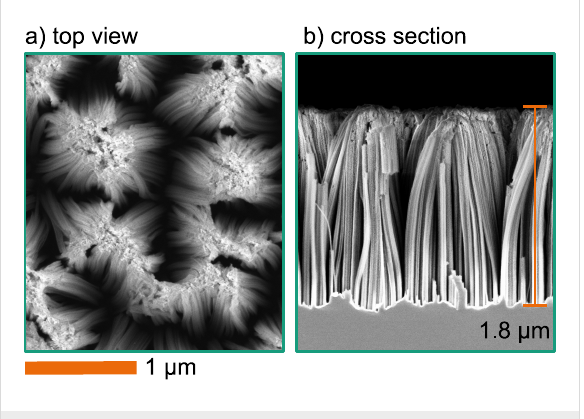
Figure 5: SEM images of etched structures (with 145 mmol/L H 2 O 2 and 1.73 mol/L HF for 10 min) using Au particles showing sticking structures. (a): Top view; (b): cross